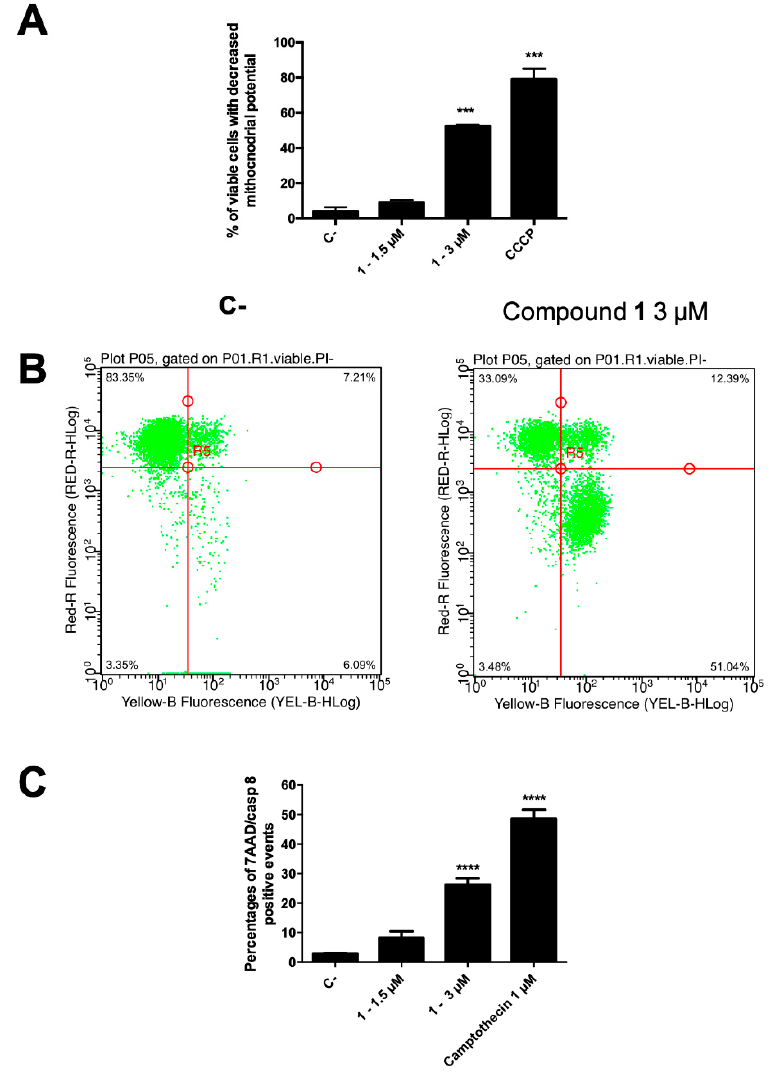
Figure 5. ( A ) Percentage of 7-AAD + and 7-AAD − cells and ( B ) representative dot plot of 7-AAD − cells with decreased mitochondrial potential of 1 -treated CCRF–CEM cells stained with DiIC1(5) and